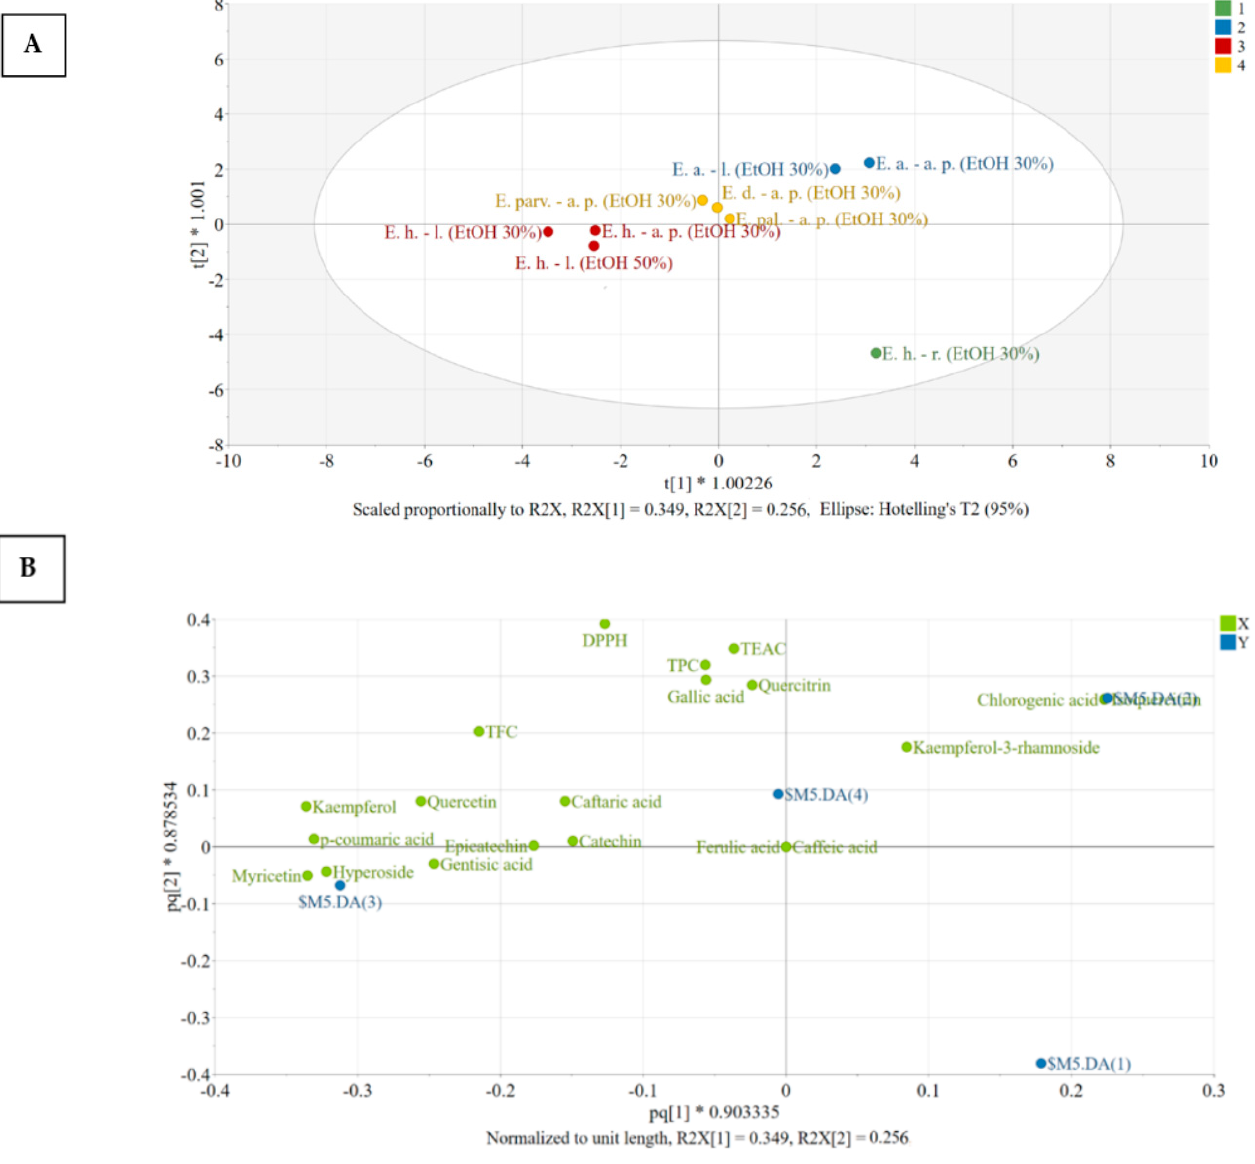
Figure 3. The score ( A ) and loading ( B ) scatter plots of the OPLS-DA model. Legend: E. h.–l.— E. hirsutum leaves; E. h.–a. p.— E. hirsutum aerial parts; E. h.–r.— E. hirsutum roots; E. parv.–a. p.— E. parviflorum aerial parts; E. pal.–a. p.— E. palustre aerial parts; E. d.–a. p.— E. dodonaei aerial parts; E.